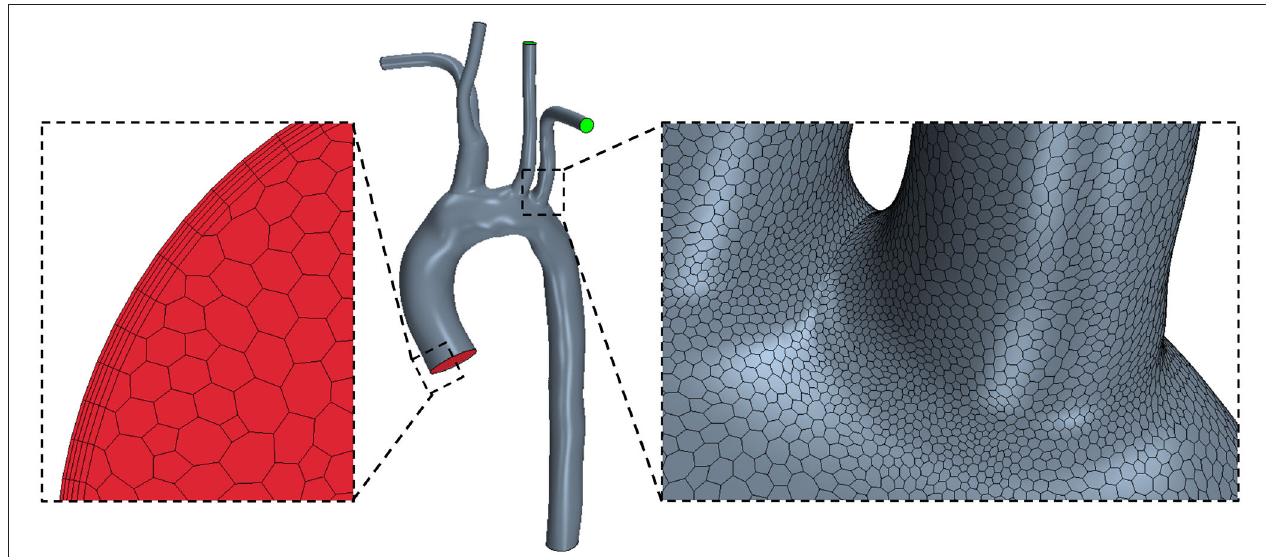
FIGURE 2 | STAR-CCM + polyhedral mesh shown on a healthy (H1) model with zoomed views of the inlet mesh with a prism boundary layer (left) and the arch surface mesh (right).